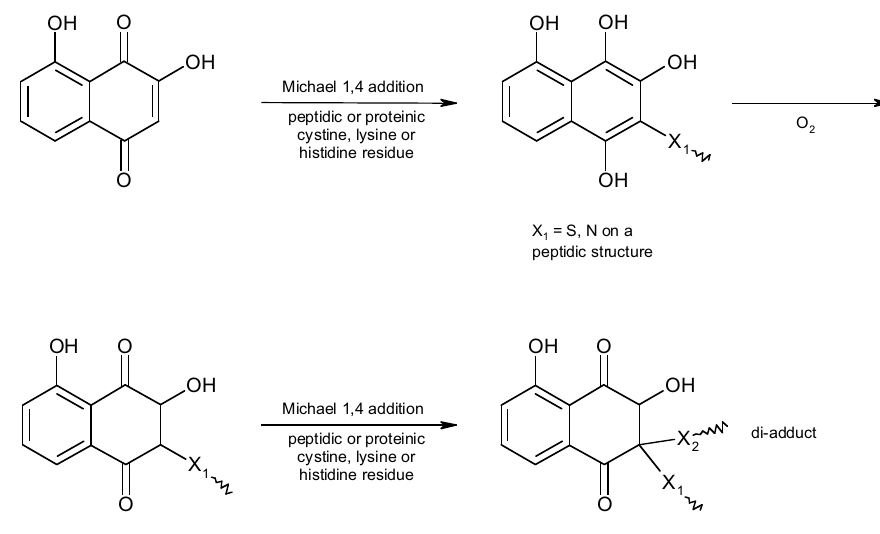
Fig. 3. Proposed mechanism of protein cross-linking induced by 1,4